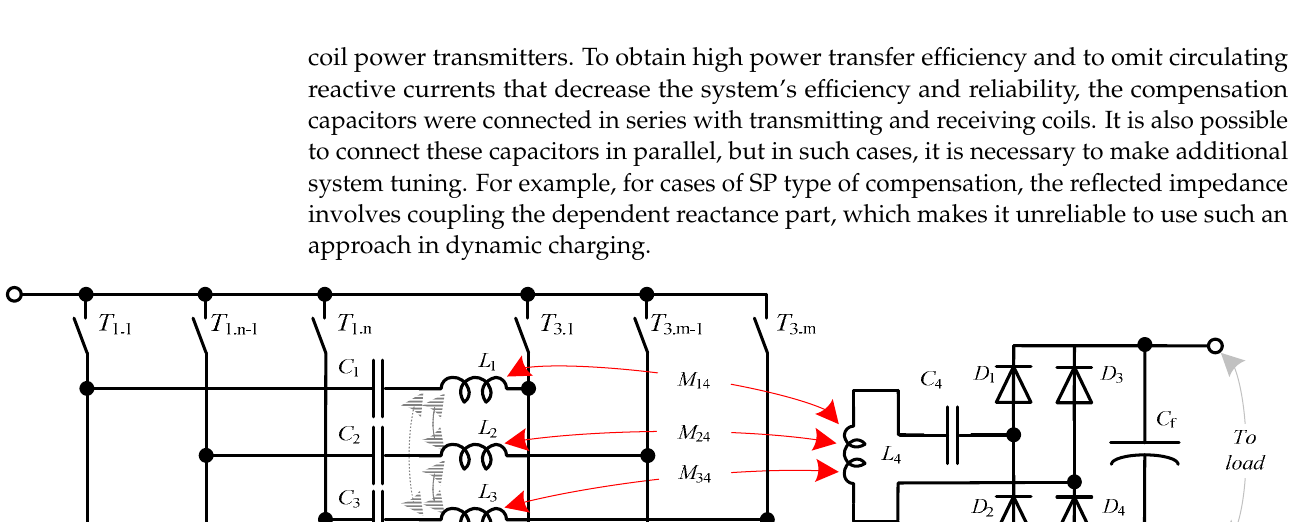
Figure 4. Inductive power transfer topology with three transmitters.